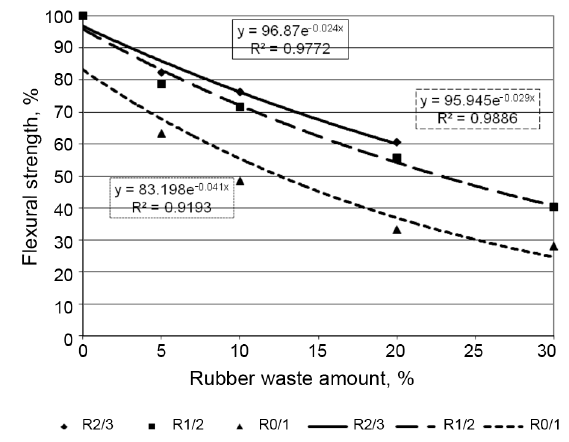
Fig. 7. Effect of CR amount and size fraction on the flexural strength of